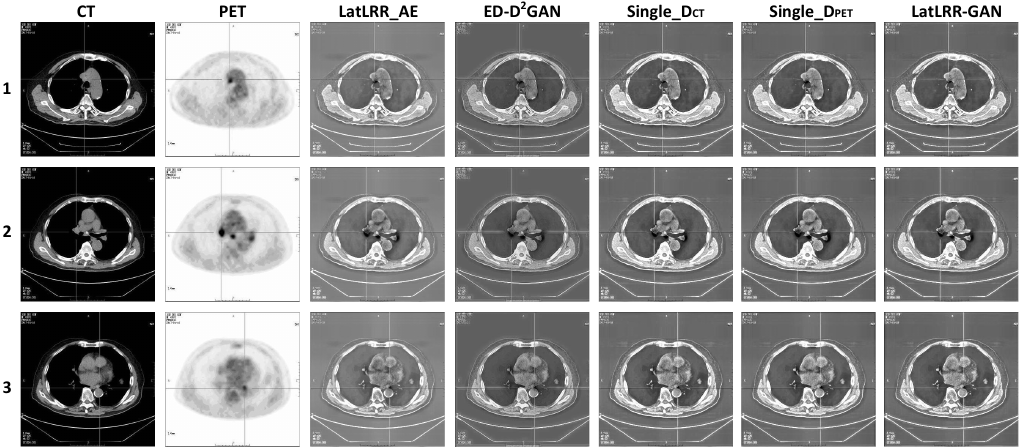
Figure 9. The fusion results of CT mediastinal window images and PET images about the ablation experiments. Method 1: LatLRR_AE; Method 2: ED-D 2 GAN; Method 3: Single_D CT ; Method 4: Sin- gle_D PET ; Method 5: LatLRR-GAN.